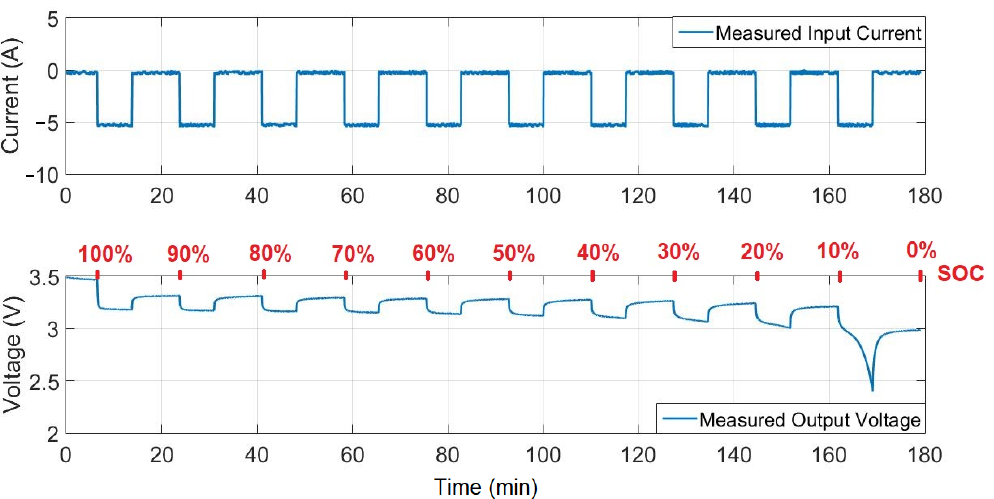
Figure 4. Complete OCV test measuring input current and output voltage.